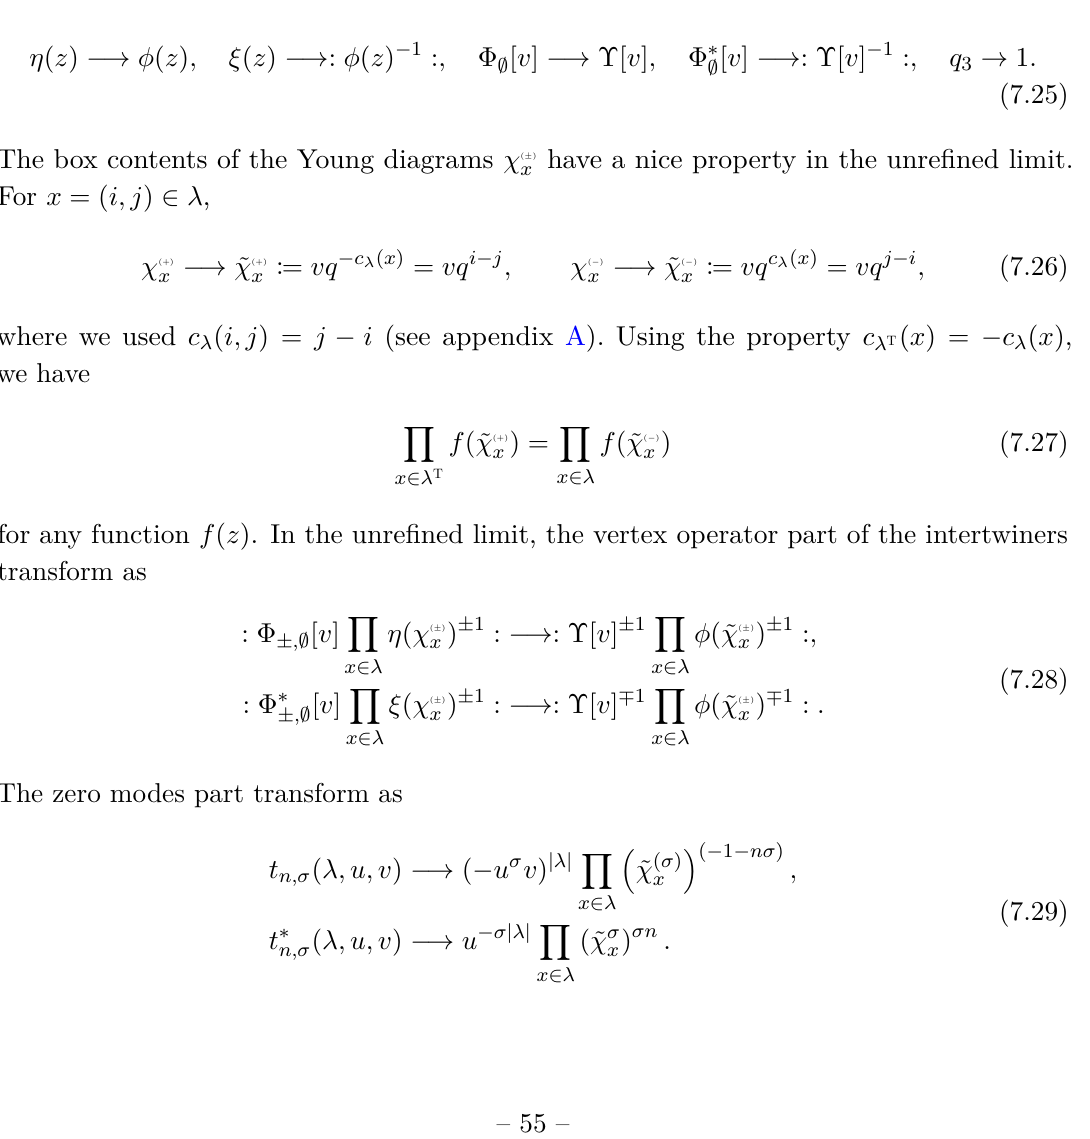
Figure 8 . Identities of intertwiners in the unrefined limit. Negative branes on one side of the NS5-brane are identical to positive branes on the other side of the NS5-brane in the unrefined limit.